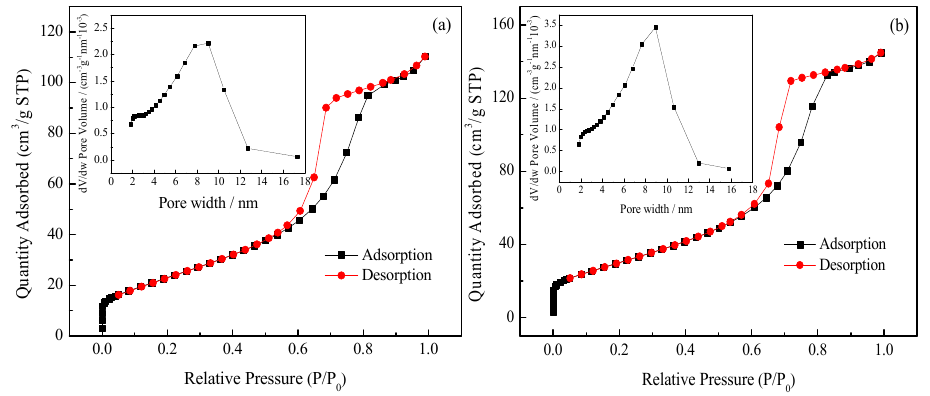
Figure 4. N 2 adsorption-desorption isotherms and pore size distributions (inset) of pure TiO 2 ( a ) and